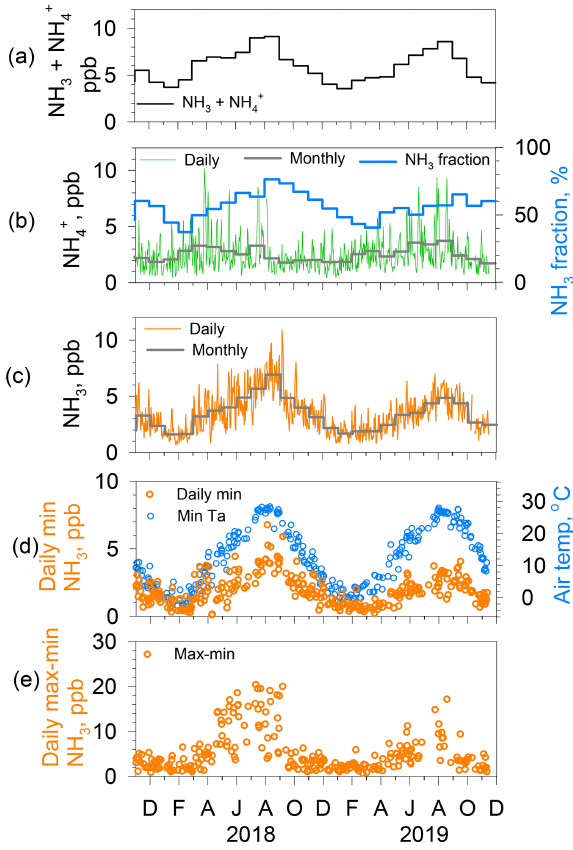
Figure 7. (a) Monthly NH 3 and NH + concentrations. (b) Daily 4 (thin green line) and monthly (thick gray line) NH + concentra- 4 tions with NH 3 fraction (thick blue line) to the NH 3 andNH + con- 4 centration. (c) Daily (thin orange line) and monthly (thick gray line) NH 3 concentrations. (d) Daily minimum NH 3 concentrations (orange circles) and minimum air temperature (blue circles) for days of both average relative humidity < 70% and daily average wind speed < 3ms − 1 . (e) Range of diurnal NH 3 concentrations (max–min: orange circles) for days of both average relative humid- ity < 70% and daily average wind speed < 3ms − 1